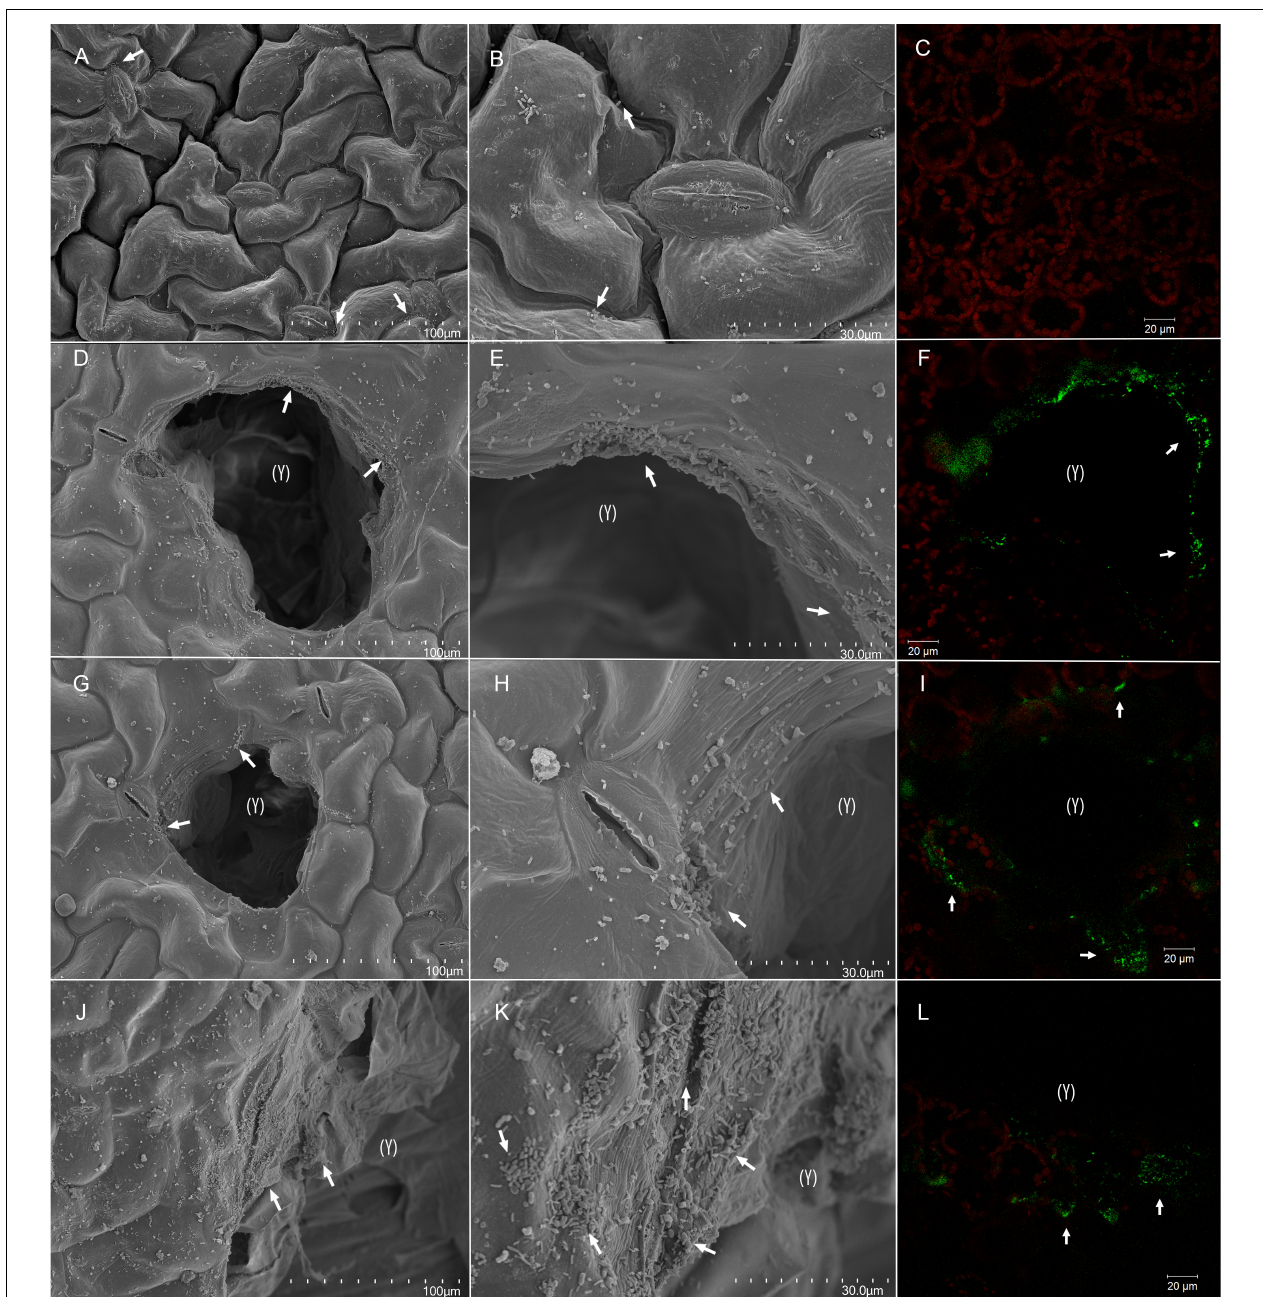
FIGURE 5 | Bacterial colonization of artificially damaged spinach ( Spinacia oleracea L.). Whole undamaged leaves (A–C) , and leaves with a low (D–F) , moderate (G–I) , and high (J–L) level of artificial damage were dip-inoculated with 10 6 CFU × mL - 1 E. coli O157:H7 bacteria and observed 2 dpi. Leaves were surface-sanitized with 0.25% sodium hypochlorite for 20 s before sampling for confocal laser scanning microscopy (CLSM). From scanning electron micrographs (SEM) (A,B,D,E,G,H,J,K) and CLSM images (C,F,I,L) , it can be observed that lesion edges, junctions between adjacent epidermal cells, and stomata were the preferred colonization sites (arrows). Red fluorescence (C,F,I,L) indicates autofluorescence of the chlorophyll within chloroplasts, and green fluorescence indicates cells of E. coli O157:H7 bacteria. Lesions are marked with (Y). Scale bars 100 µ m (A,D,G,J) , 30 µ m (B,E,H,K) , and 20 µ m (C,F,I,L)